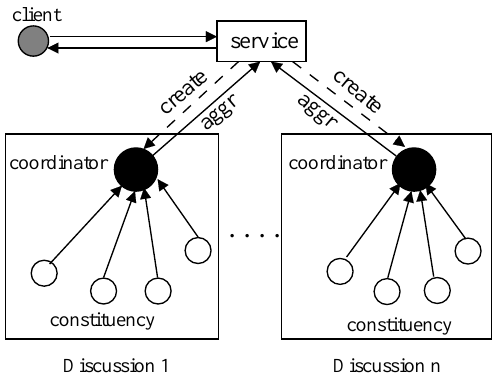
Figure 10. Twitter-like Messaging